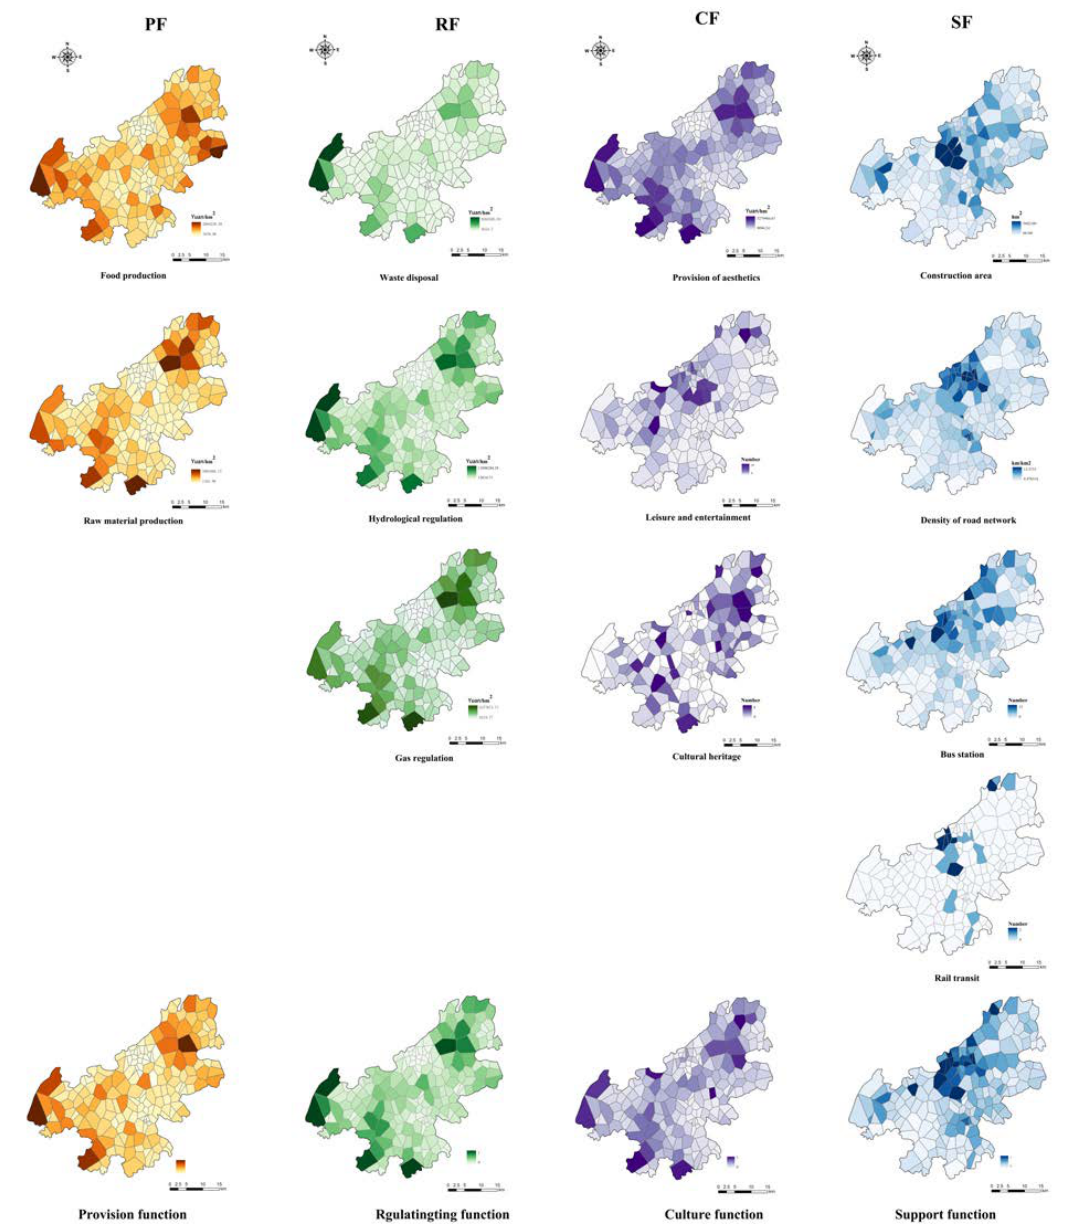
Figure 4. Spatial distribution characteristics of landscape functions in Jiangning District, Nanjing.